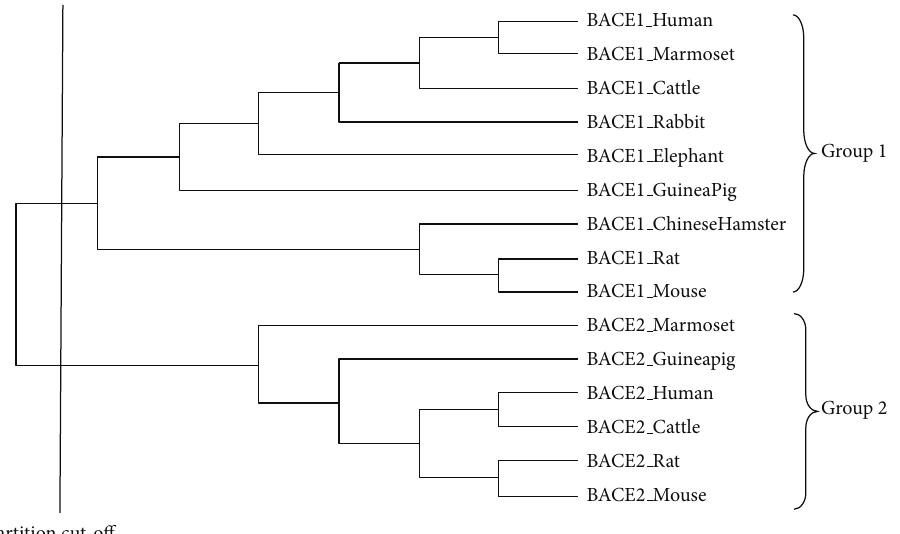
Figure 1: Evolutionary trace based cladogram of selected BACE1 and BACE2 protein sequences from UniProt database. ET partition cut-off divides the phylogenetic tree into Group 1 (BACE1) and Group 2